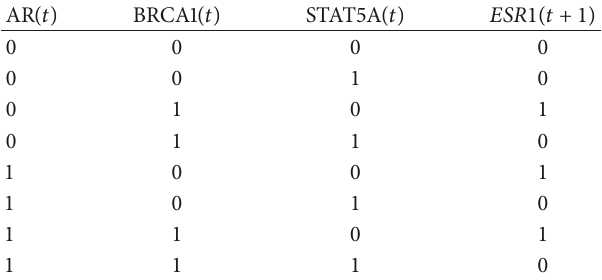
Table 1: ESR1 truth